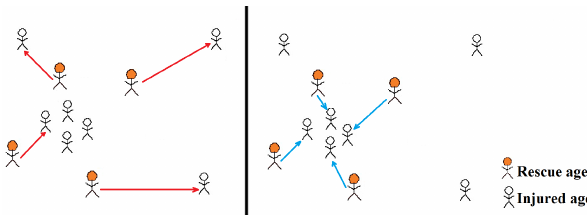
Figure 4. Best density strategy illustration. Blue arrows indicate the successful rescuers in strategy 2, and red arrows indicate the final results for strategy